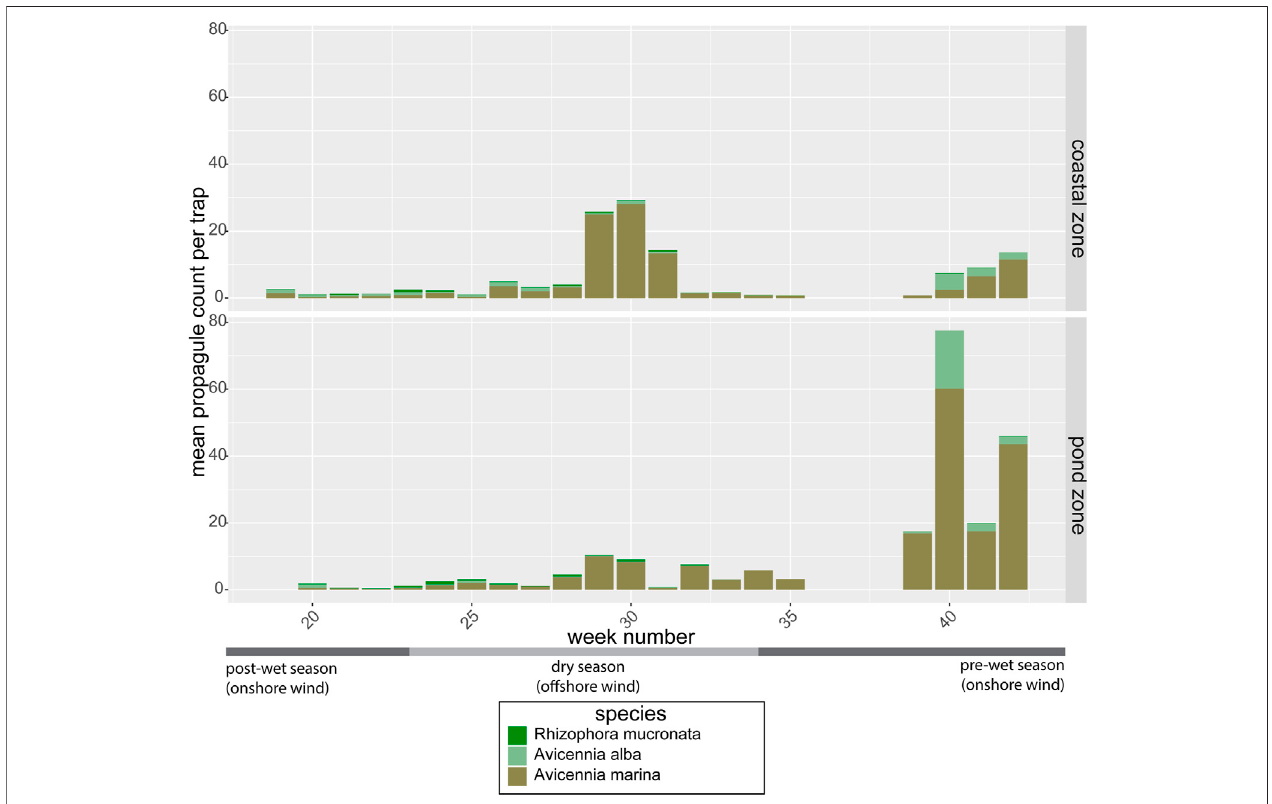
FIGURE5| Averageweeklypropagulecountsofthethreemostabundantmangrovespeciespertrapinthecoastalzone(propagulesource)andinthepondzone. Data from the mid-wet season are missing due to storm damage to the traps.